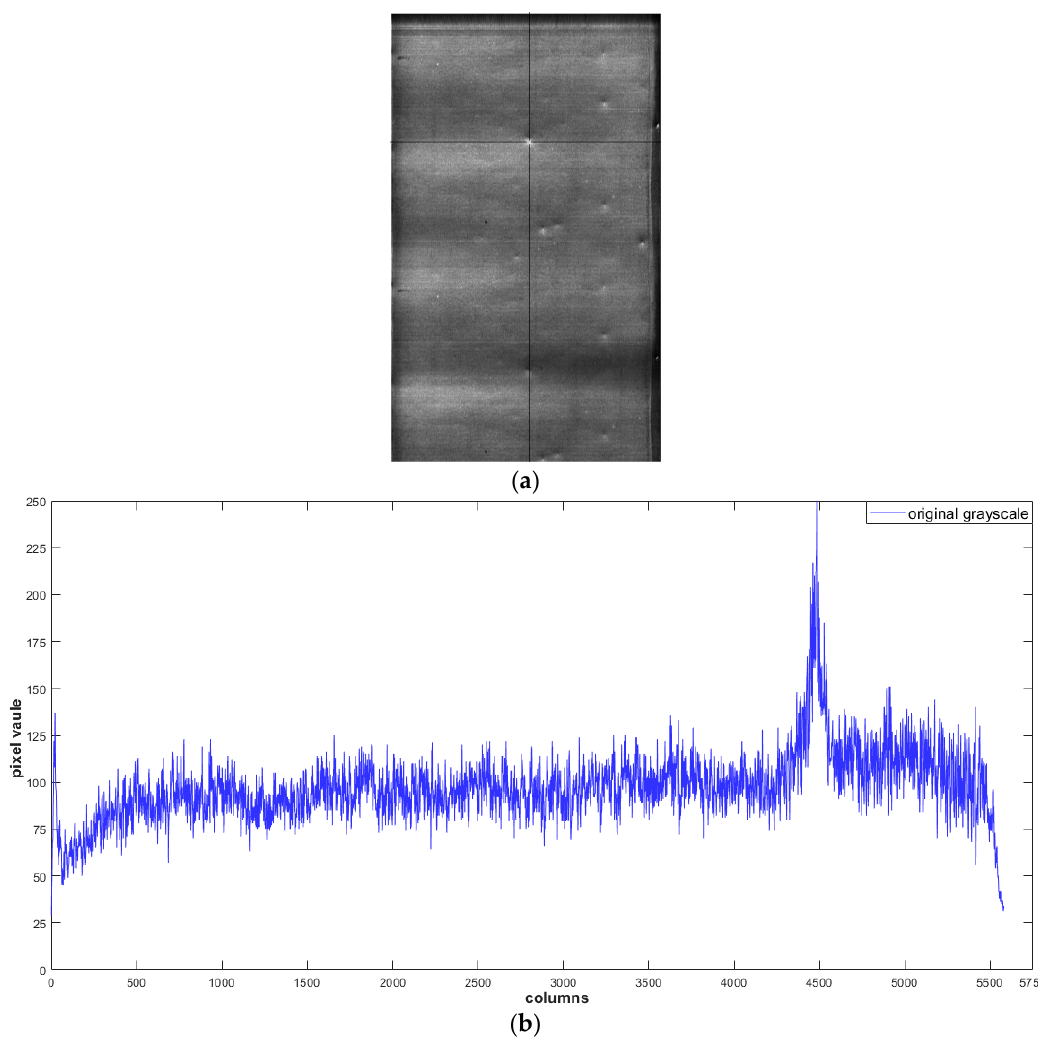
Figure 6. The grayscale variation of original ROI image of the battery. ( a ) ROI; ( b ) The grayscale variation on a row of the ROI image.